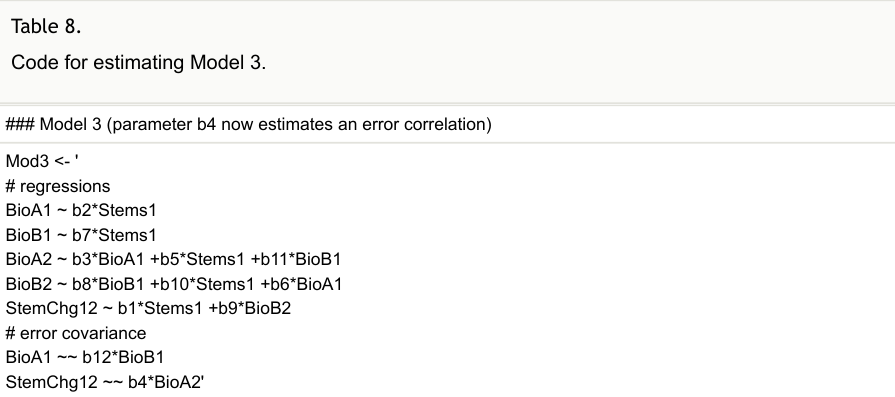
Code for estimating Model